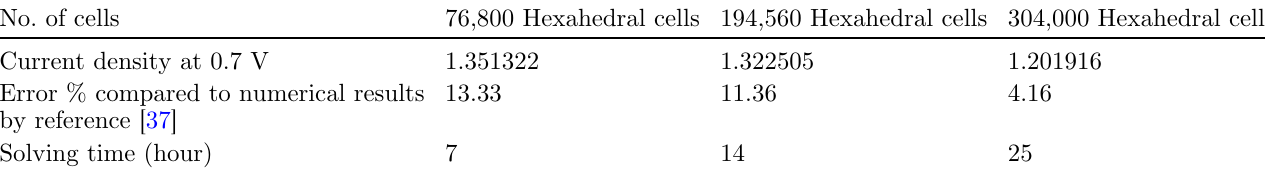
Table 2. Mesh independency